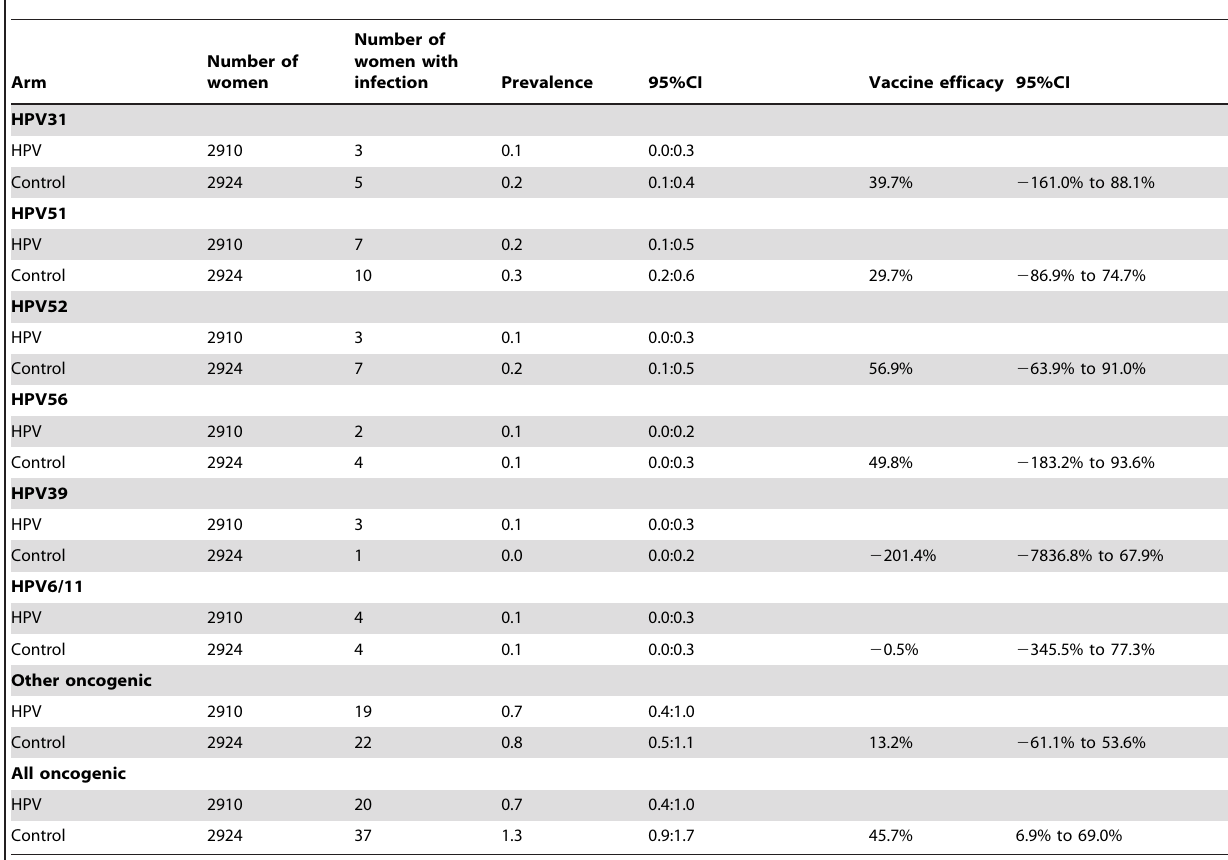
Table 4. Estimated vaccine efficacy against oral infections with other HPV